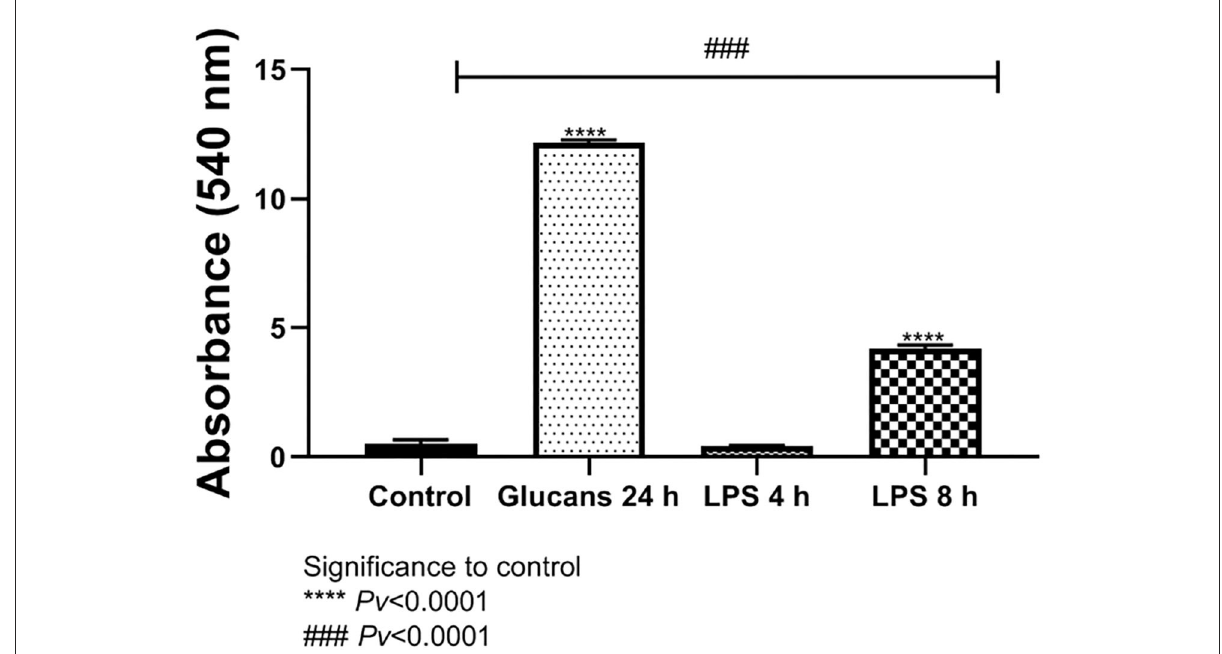
FIGURE3 Release of NO to the medium after exposure to algae beta-glucans glucans for 24h, or LPS. ****Pv < 0.0001 compared to the control group. ### Pv < 0.0001 compared the exposure to beta-glucans in contrast to LPS for 4 and 8h (n =